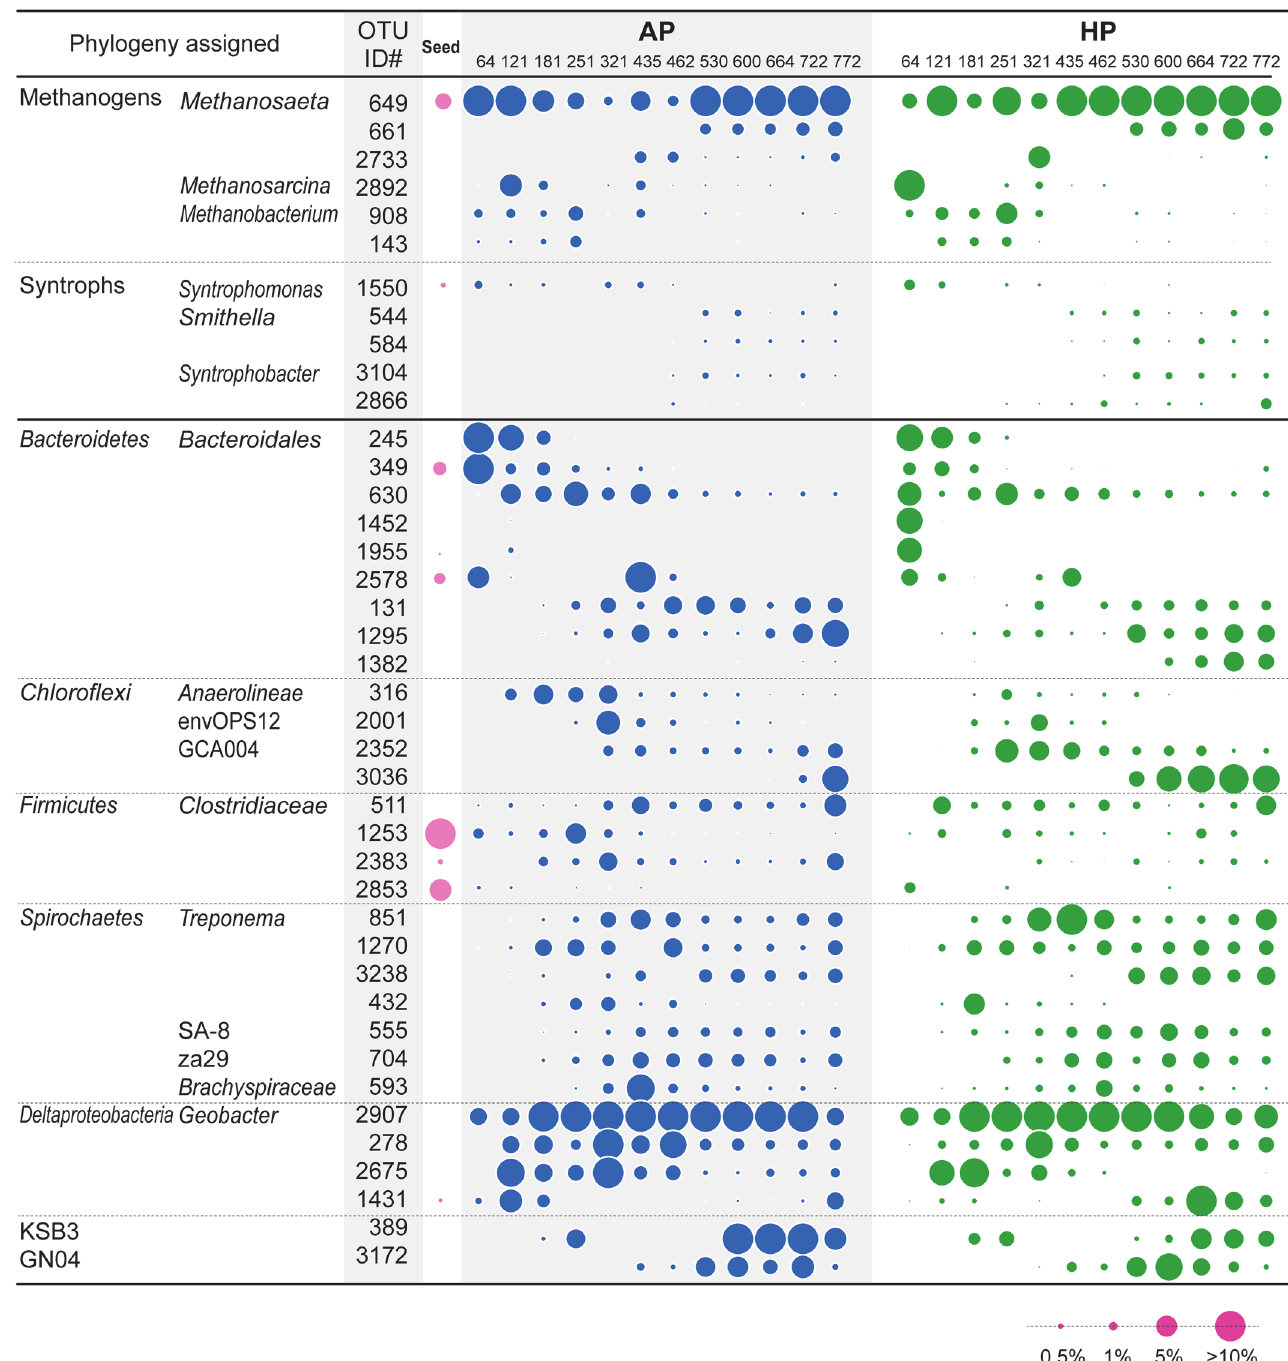
Fig 4. Bubble plot indicates the relative abundances of major OTUs retrieved from anaerobic packed-bed (AP) and hybrid packed-bed (HP) reactors. The numbers below AP and HP on top row indicate days of the operation for biomass sampling.